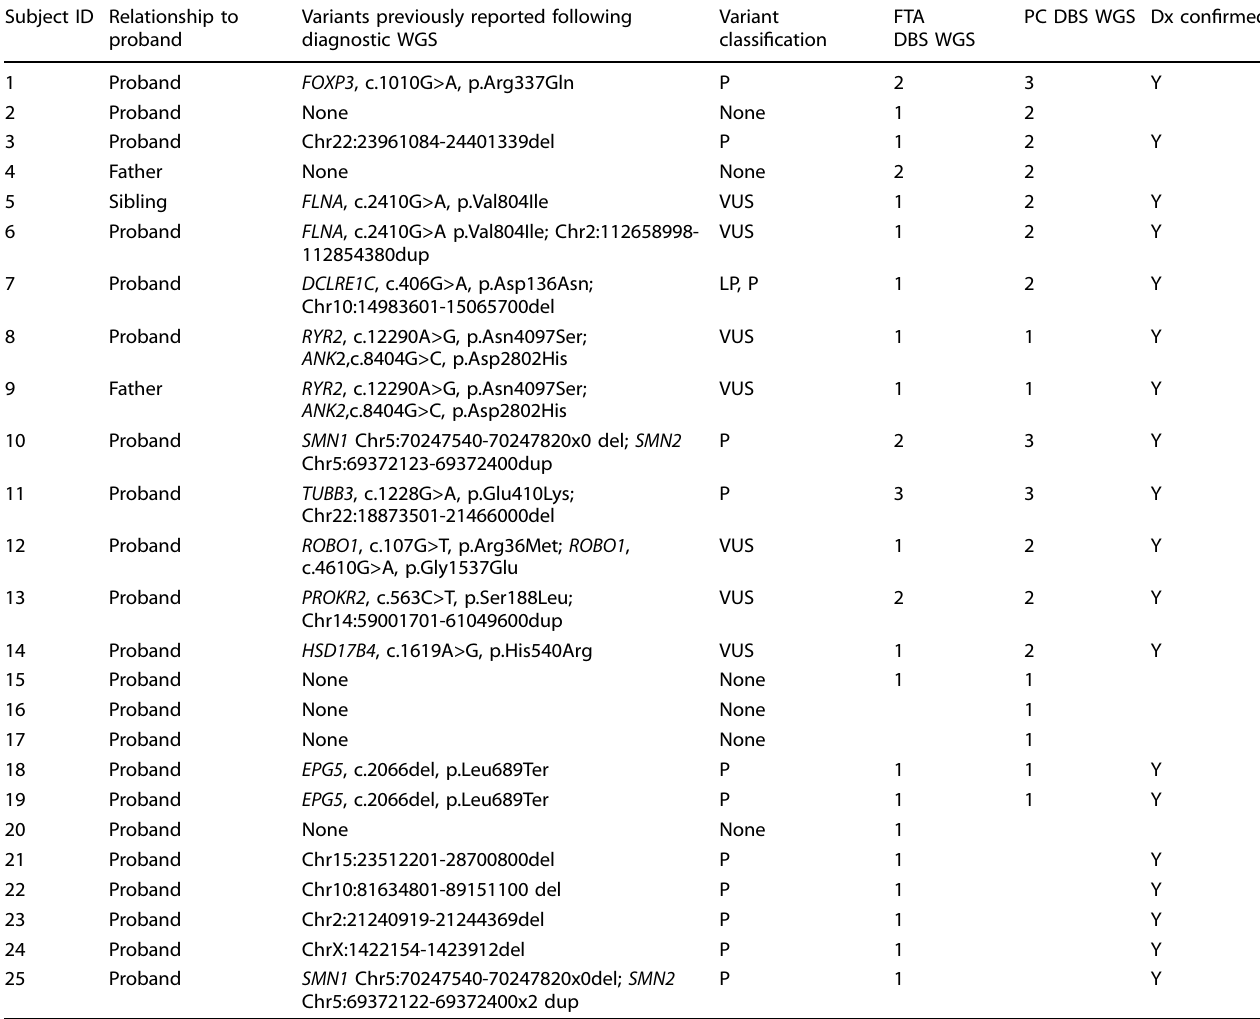
Table 1. Concordance of variants reported clinically in diagnostic WGS of 25 blood samples and WGS from 63 manufactured DBS. Subject ID Relationship to